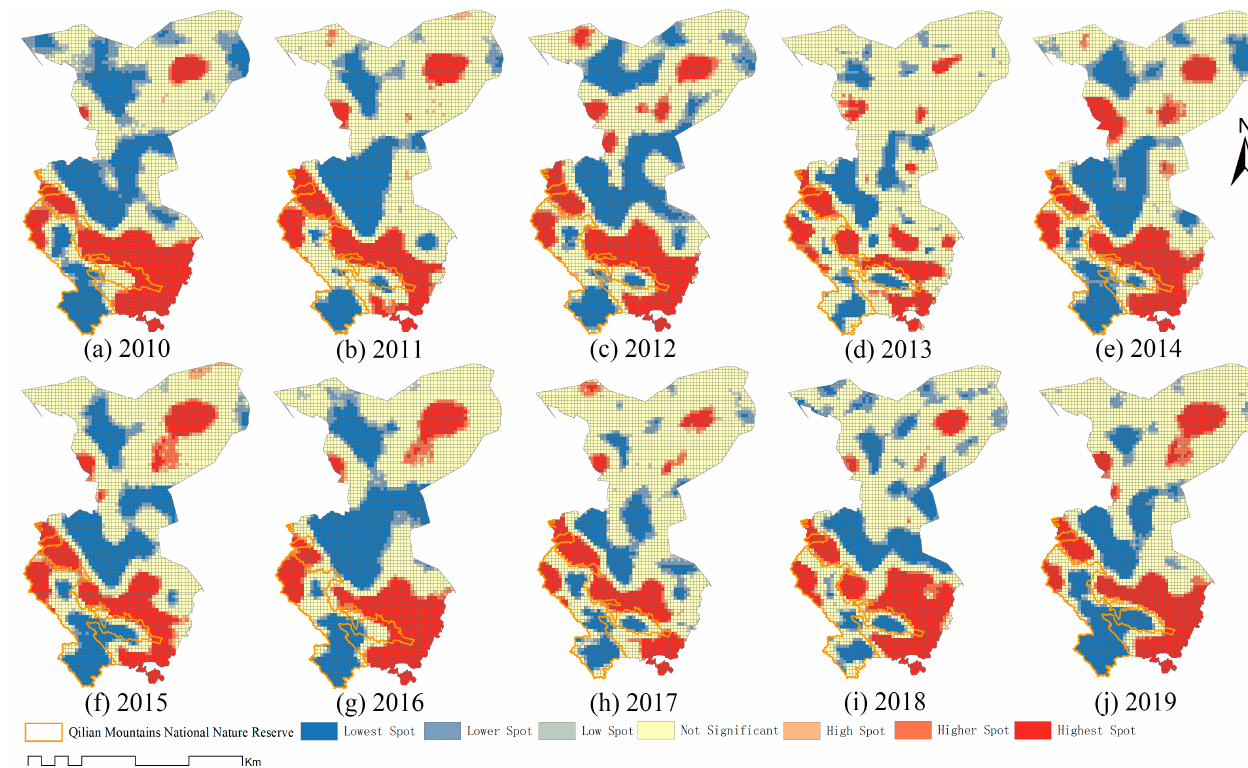
Figure 8. The distribution of ecological risks aggregation in 2010–2019.